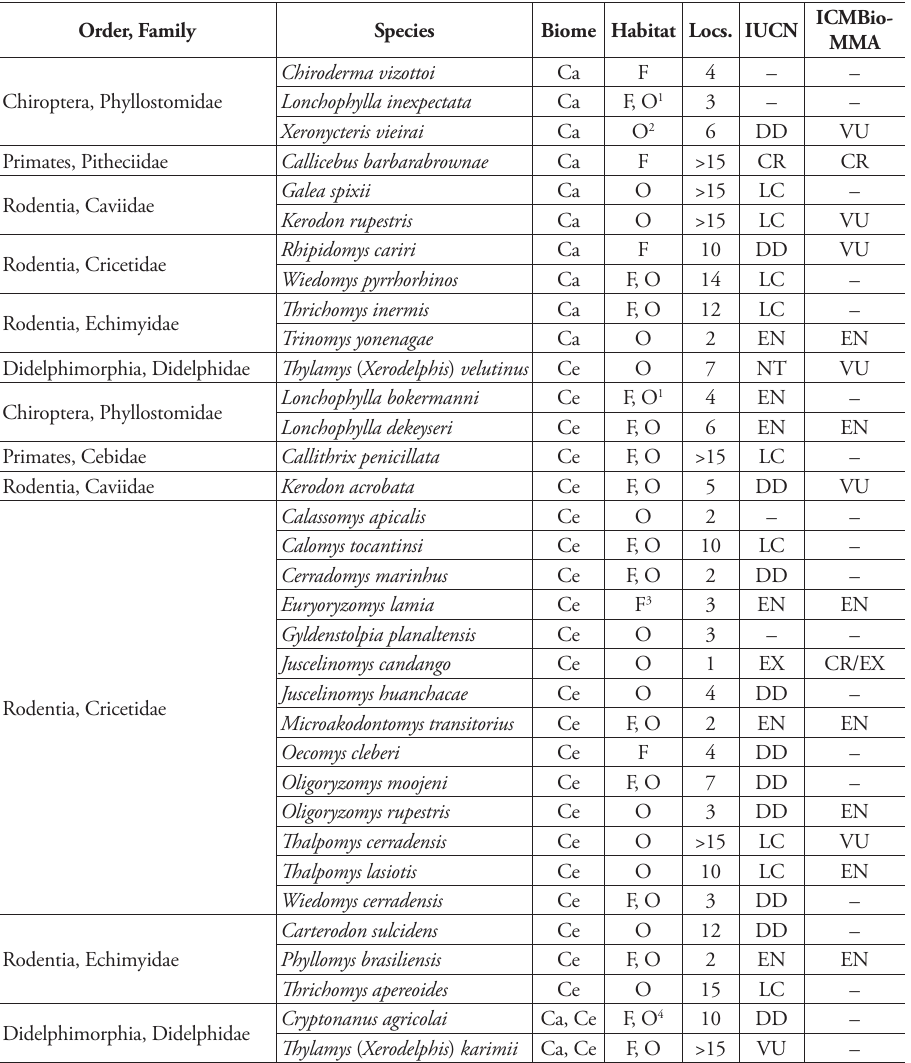
Table 1. List of mammal species endemic to the Caatinga, the Cerrado, or both, and their habitat and conservation statuses. Biome: Caatinga (Ca), Cerrado (Ce). Habitat: forest (F), open (O; e.g., campo limpo, cerrado sensu stricto ; Oliveira and Marquis 2002), Locs: approximate number of localities for which voucher specimens exist according to the literature (see Species Accounts). IUCN: conservation status according to the International Union for the Conservation of Nature (Red List of Threatened Species ver- sion 3.1). ICMBio-MMA: conservation status according to the Instituto Chico Mendes de Conservação da Biodiversidade - Ministério do Meio Ambiente of Brazil (ICMBio-MMA 2016). Categories for conservation statuses: Data Deficient (DD), Low Concern (LC), Vulnerable (VU), Near Threatened (NT), Endangered (EN), Critically Endangered (CR), Extinct (EX); species that have not been evaluated by the IUCN or the ICMBio-MMA are indicated with m-dashes. Differences with respect to previous lists (from the lit- erature) are discussed in the Results